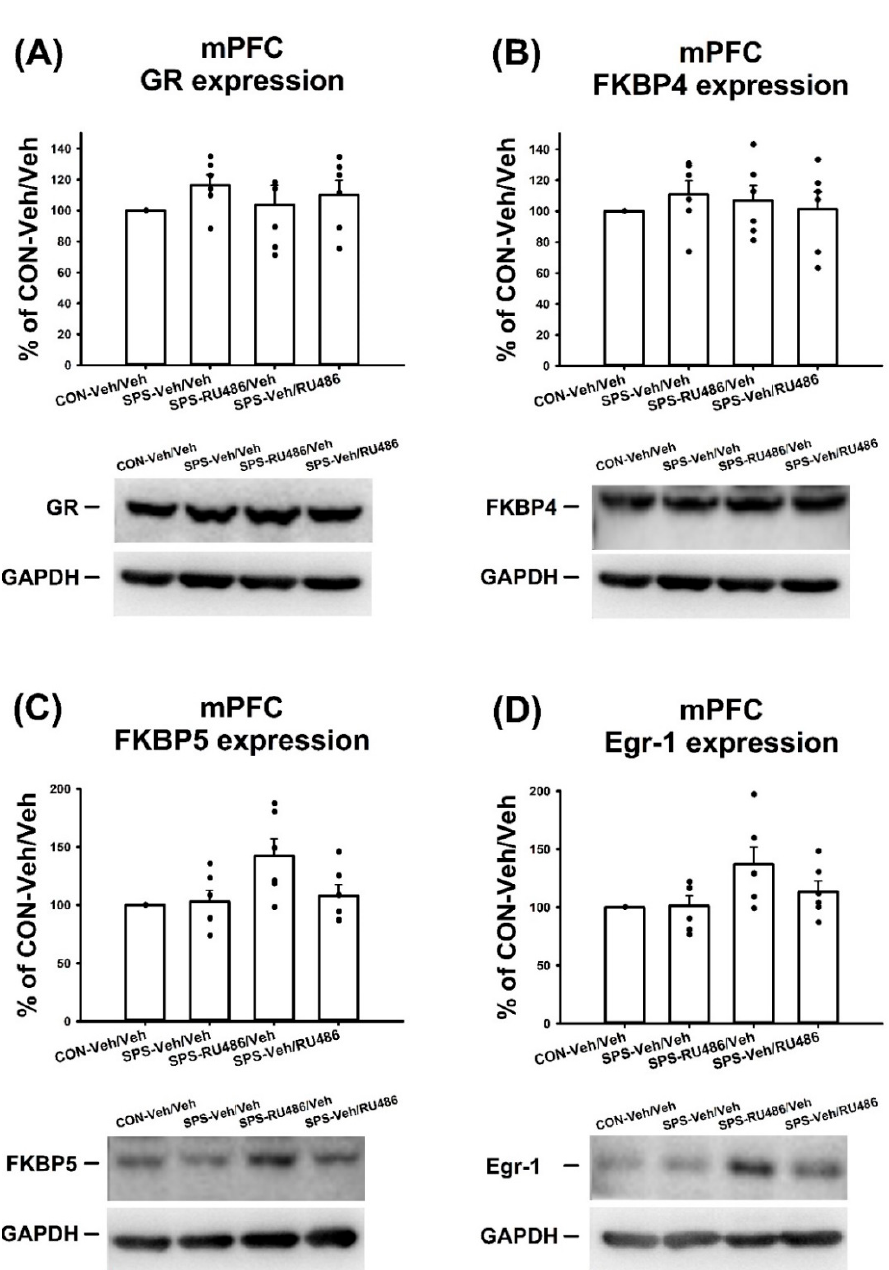
Figure 4. The expressions of the ( A ) GR, ( B ) FKBP4, ( C ) FKBP5, and ( D ) Egr ‐ 1 in the mPFC after SPS paradigm and early/late RU486 intervention. The data represent the mean ± SEM. n = 6 for each group. Statistical analysis was employed with a one ‐ way ANOVA followed by Bonferroni post hoc testing.